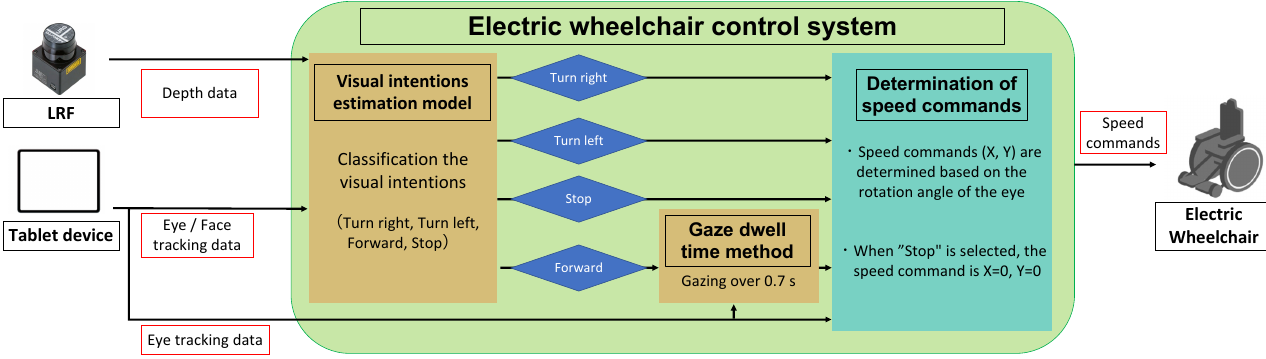
Figure 2. Block diagram of the electric wheelchair control